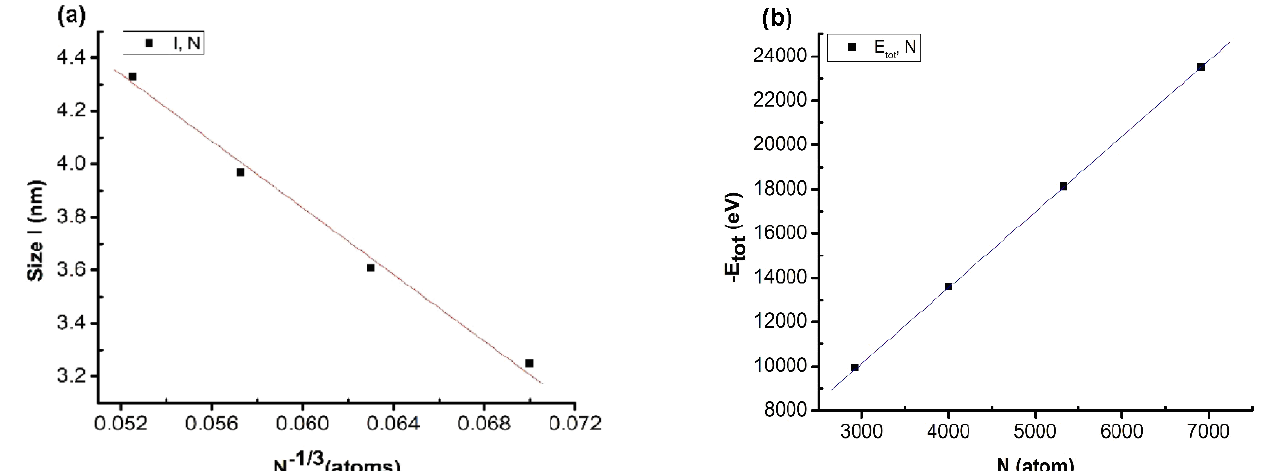
Figure 3. Relationship between number of atoms and size ( a ) and between number of atoms and total energy of the system ( b ) when changing the atom number.